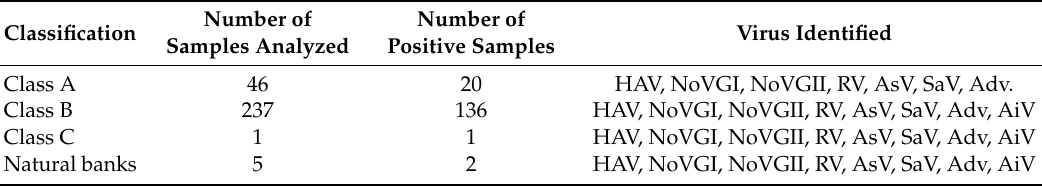
Table 7. Virus positivity among di ff erent sampling class